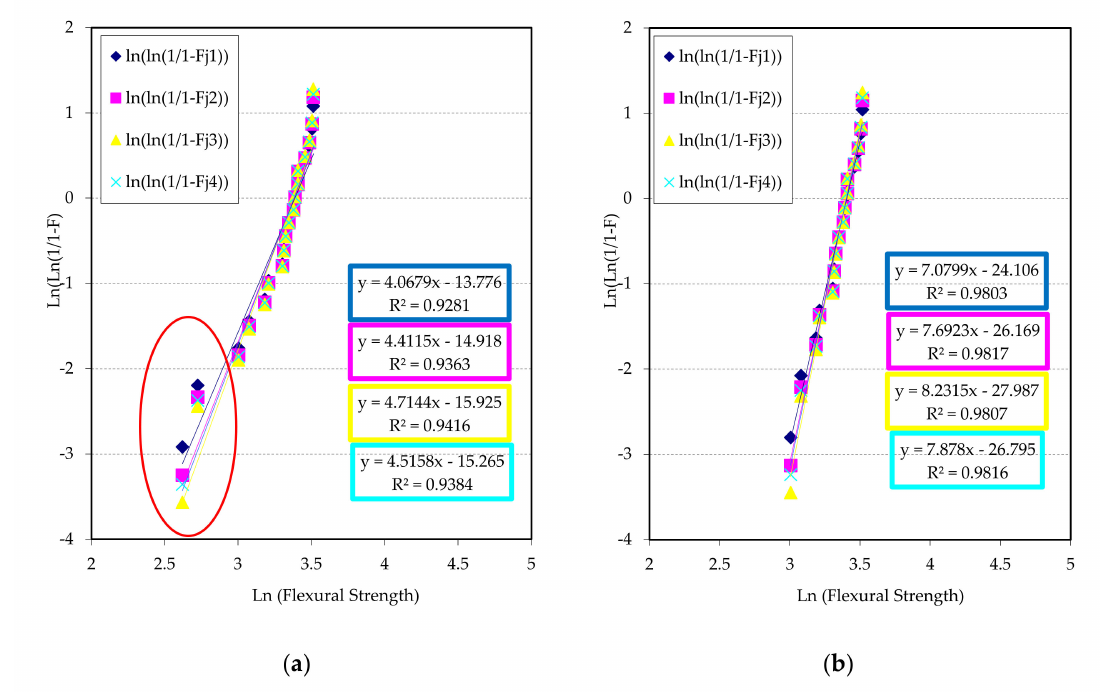
Figure 11. Weibull plots for chosen failure estimators using flexural strength as a key property for tests of conditions G2: ( a ) for all samples and ( b ) eliminated samples with premature